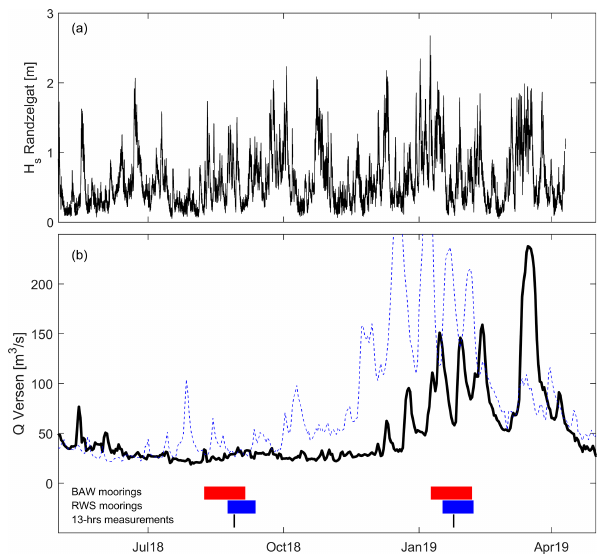
Figure 3. Wave height H s measured at station Randzelgat No- ord (a) and discharge of the Ems River at Versen (b) from 1 May 2018 to 1 May 2019, with deployment dates of BAW frames, RWS frames, and the 13h measurements added to (b) . The dashed blue discharge in (b) is the discharge of the period 1 May 2017 to 1 May